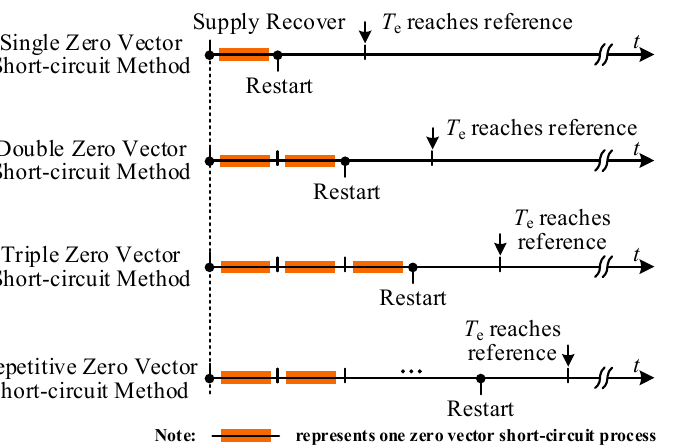
Figure 2. Influence of different zero vector short-circuit methods on the rise time of electromagnetic torque after power supply